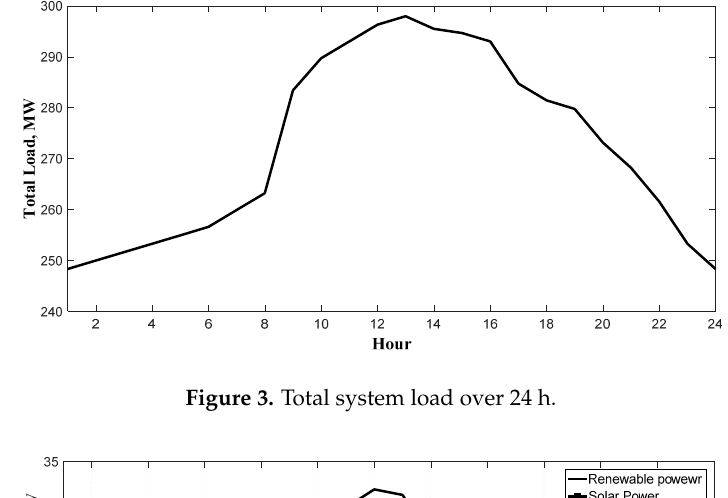
Figure 3. Total system load over 24 h.